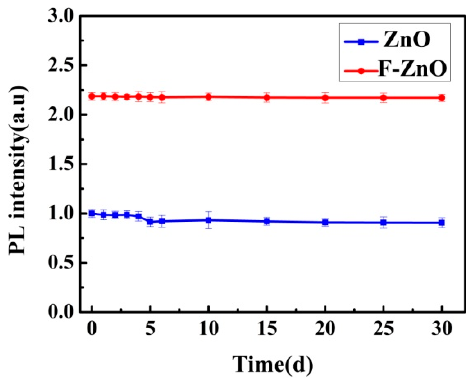
Figure 6. The PL intensity stability of ZnO films with and without SF 6 plasma treatment.